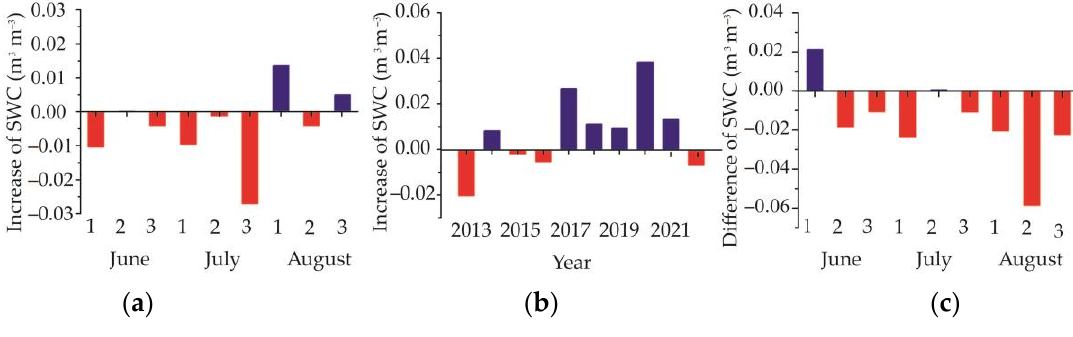
Figure 14. Soil moisture increment, where ( a ) shows the increase in soil moisture in each 10–day period in the summer of 2022, that is, the difference between the current 10–day period and the previous 10–day period; ( b ) shows the difference between the average soil volume water content from July to August and that in May of that year; and ( c ) shows the moisture difference between each 10–day period in the summer of 2022 and the corresponding 10 days in 2021.